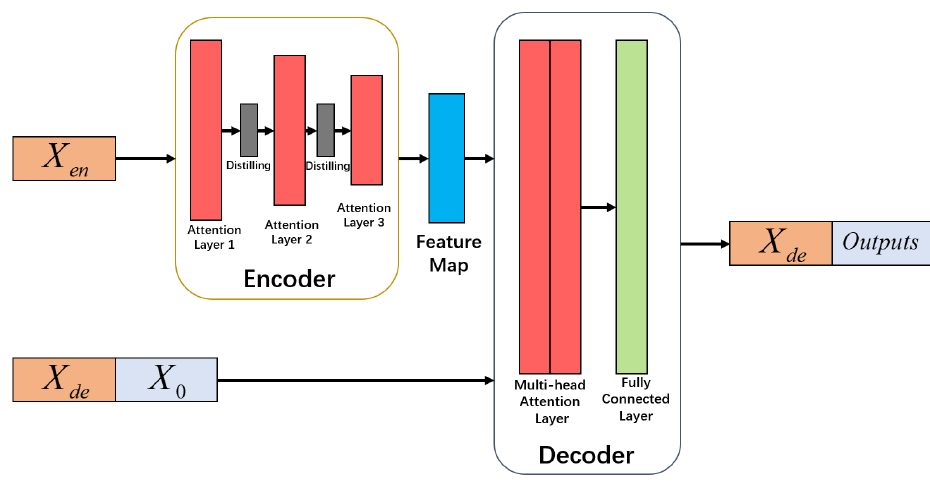
Figure 5. The structure of encoder–decoder component. The inputs of the encoder–decoder component is shown in Figure 6.